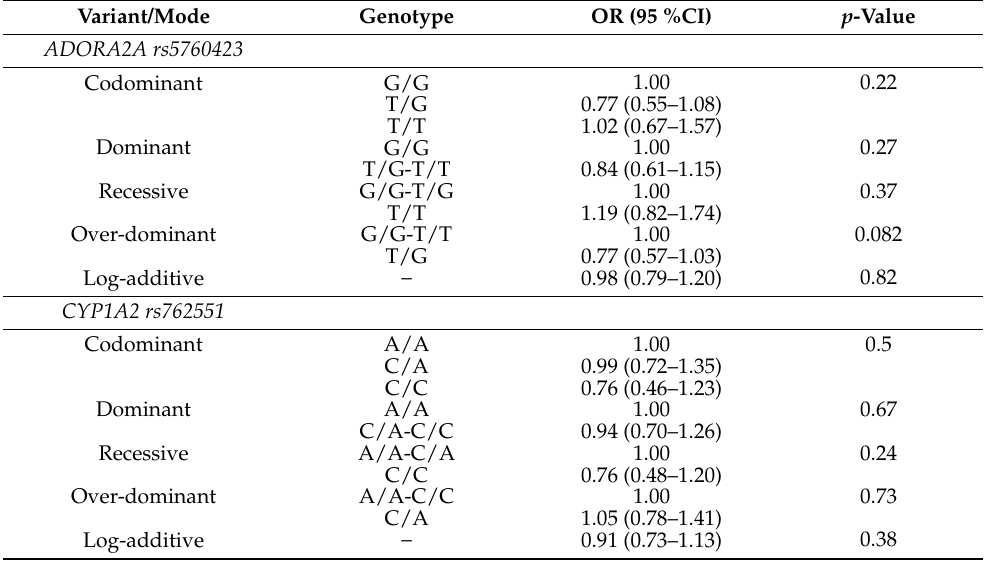
Table 3. Single locus analysis for association among ADORA2A rs5760423 , CYP1A2 rs762551 and PD in co-dominant, dominant, recessive over-dominant and log-additive